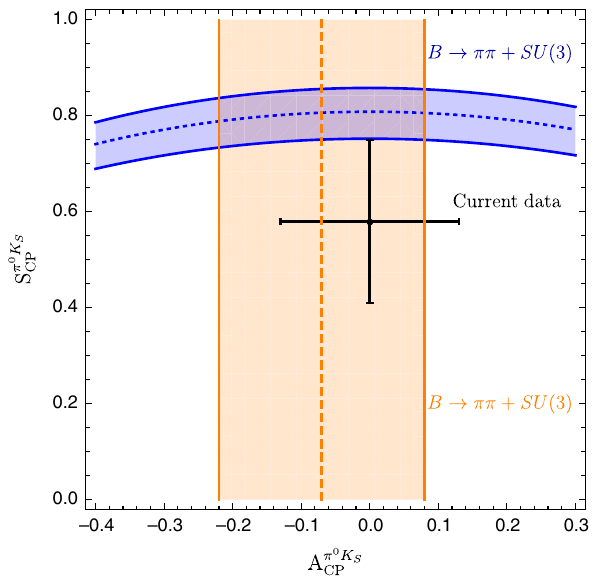
→ π 0 K S observables for d